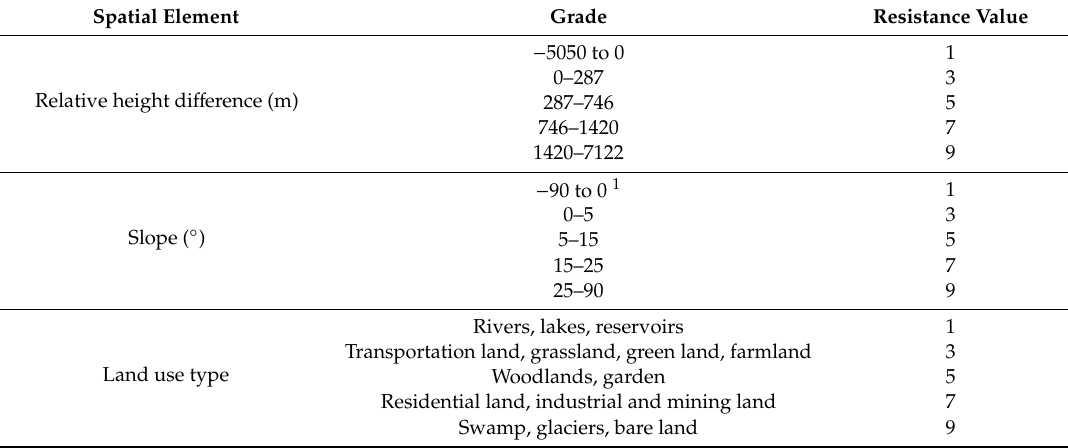
Table 1. Resistance classification and assignment of di ff erent spatial